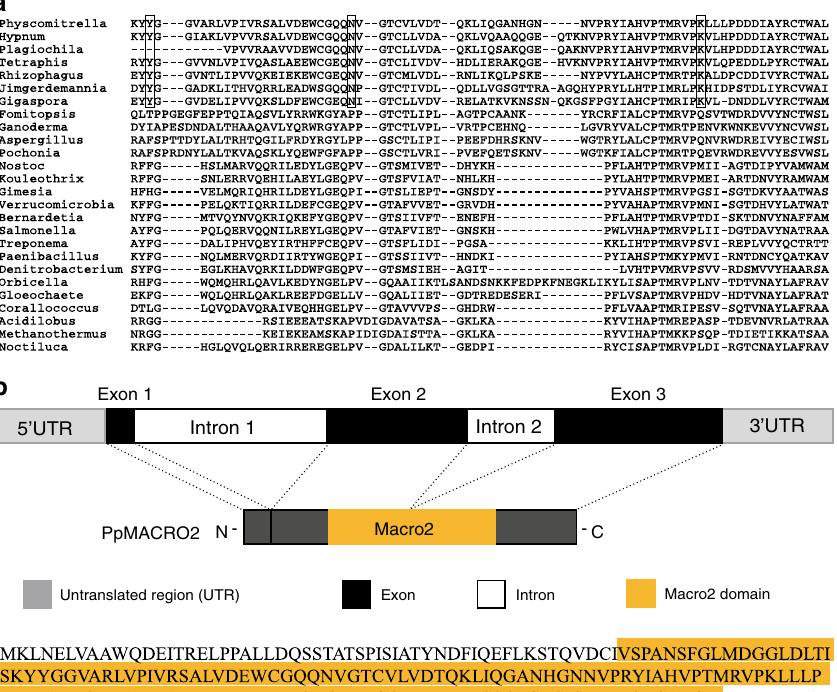
Fig. 1 PpMACRO2 sequence relationship and gene annotation. a Multiple alignment for PpMACRO2 protein sequence and homologs sampled from different major groups. Boxes in the alignment show amino acids uniquely shared by bryophytes and Mucoromycota fungi. Detailed molecular phylogeny of PpMACRO2 and homologs is shown in Supplementary Figs. 4 and 5. b Schematic diagram of PpMACRO2 gene structure and encoded protein sequence based on RT-PCR and sequencing evidence. Exons 1, 2, and 3 correspond to exons 1, 3, and 4, respectively, of the P. patens v3.3 annotation in